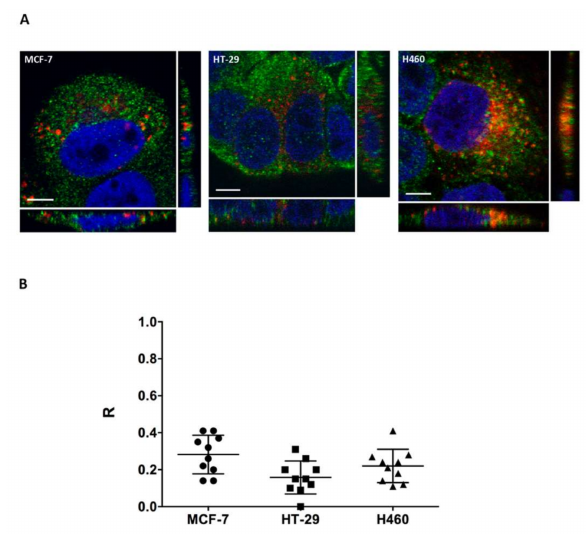
Figure 6. ( A ) COMMD1 is partially located at the endosomes based on the co-localization of COMMD1 (green) and Rab5A (red) observed in the three cell lines used (scale bar = 5 µ m); ( B ) co-localization between COMMD1 and Rab5A was evaluated by image analysis. All three cell lines analyzed showed similar levels of co-localization between Rab5A and COMMD1, as expressed by Pearson’s coefficient (R). COMMD1 in green, Rab5A in red and nuclei in blue.